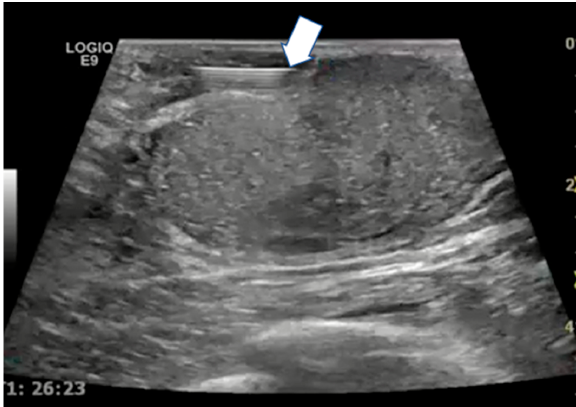
Figure 7. Ultrasound scan with linear probe showing the tip of the needle used for hydrodissection (arrow) to inject saline between the tumor and the skin or ductal structures. (arrow) to inject saline between the tumor and the skin or ductal